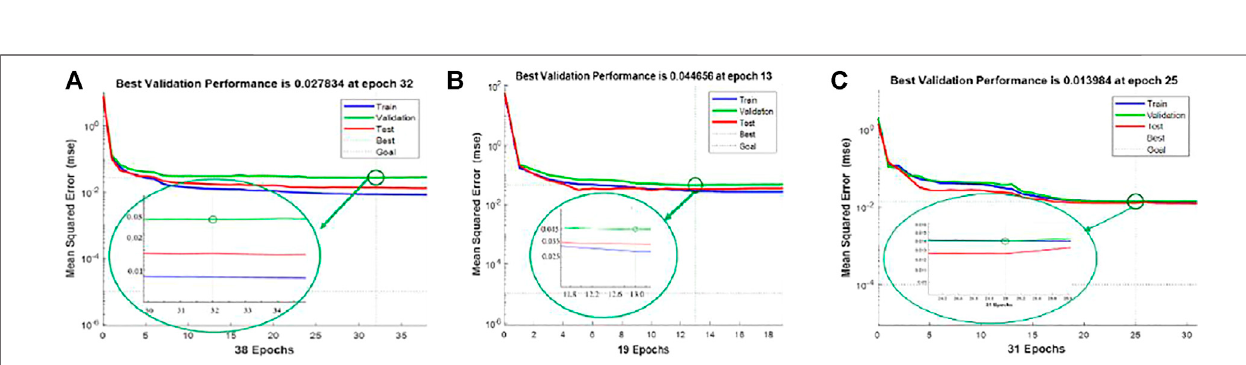
FIGURE9| Trainingresultsofdifferentalgorithms. (A) TrainingresultoftheBPneuralnetworkalgorithm. (B) TrainingresultoftheGA-BPneuralnetworkalgorithm. (C) Training result of the PSO-BP neural network algorithm.